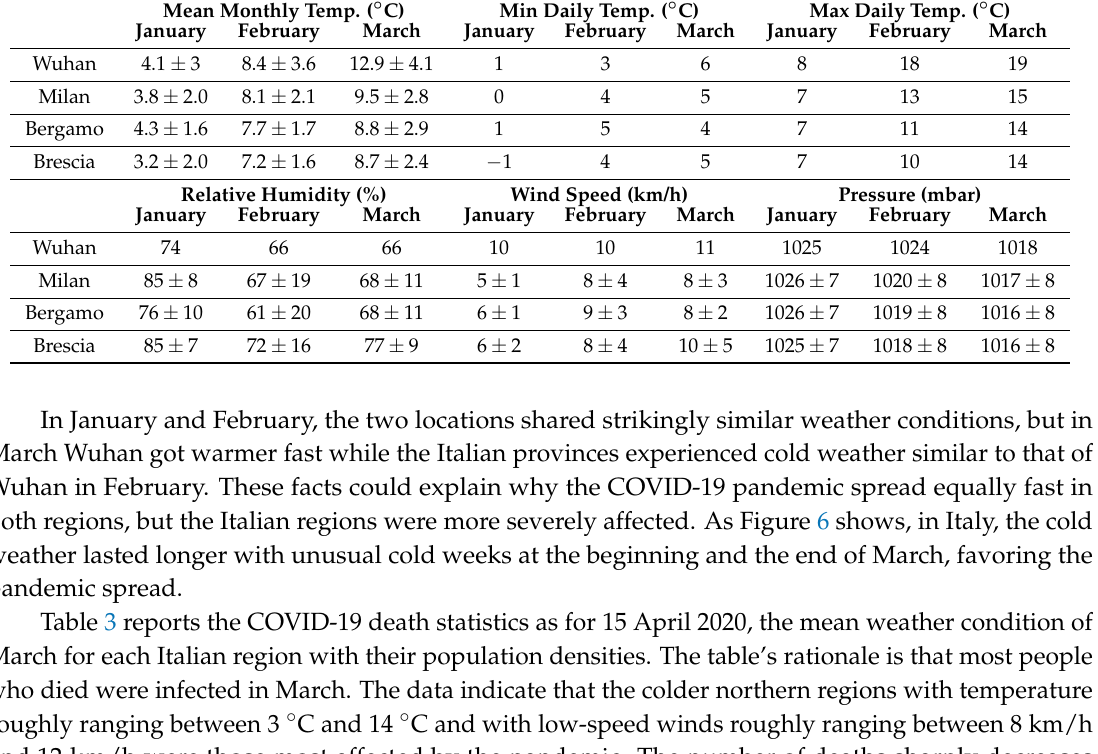
Table 2. Monthly mean weather indexes for Wuhan, Milan, Bergamo and Brescia in 2020. Mean Monthly Temp. ( ◦ C) Min Daily Temp. ( ◦ C) Max Daily Temp. ( ◦ C) January February March